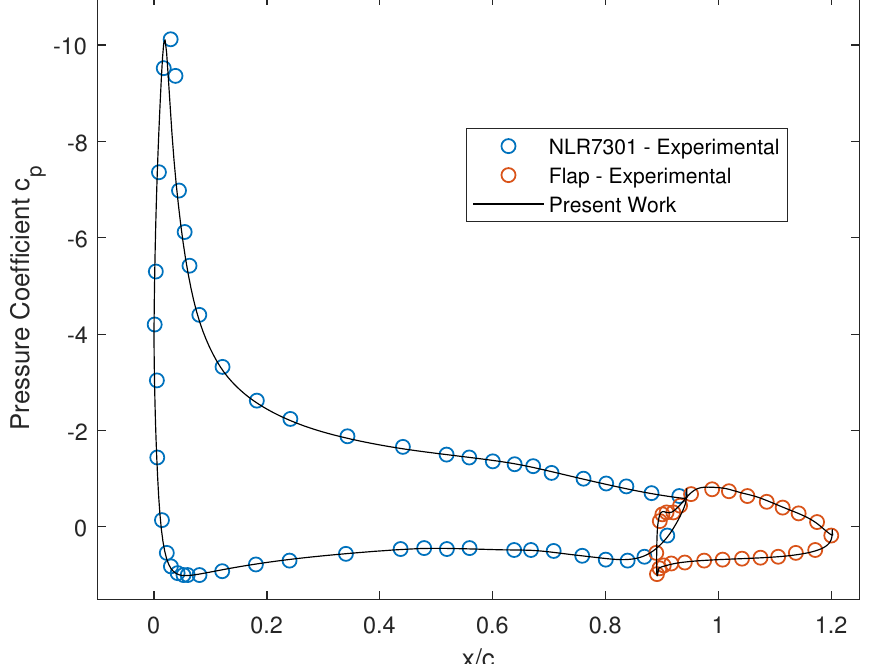
Figure 5. Comparison of experimental and numerical surface pressure distributions at α = 10.1 ◦ and M ∞ = 0.185 of the NLR 7301 airfoil with trailing-edge